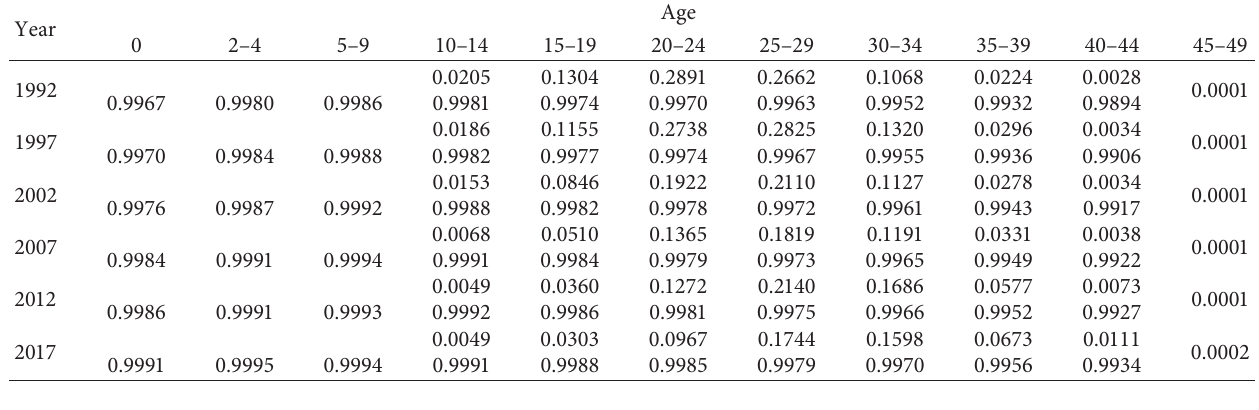
Table 2: PPMs with the first row and subdiagonal elements (1992–2017).